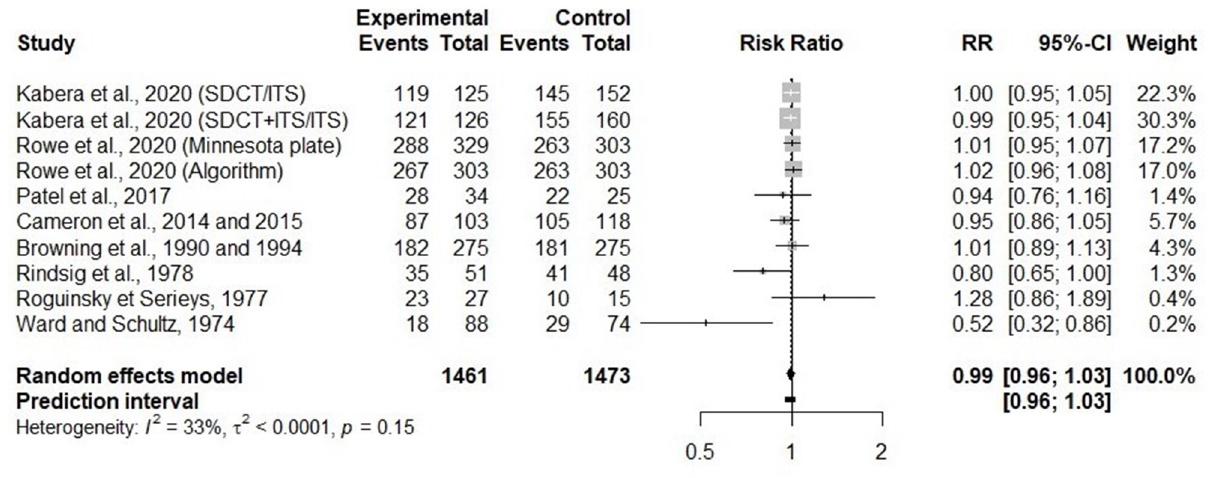
each trial, as well as summaries of RR for trials using ITS or